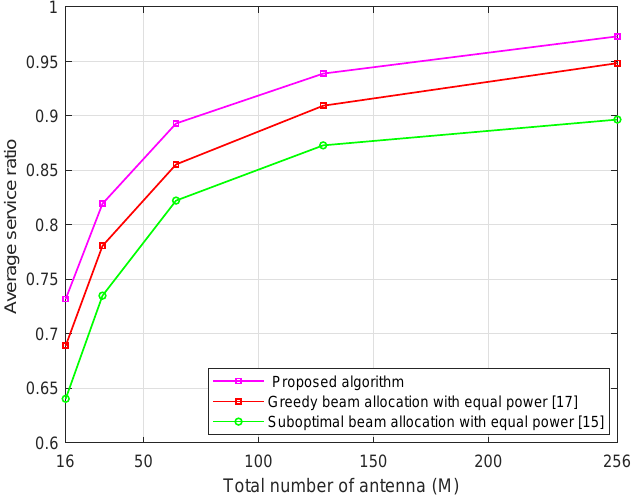
Figure 5. Average service ratio versus total number of antennas M with α = 2, U = 10, P t = 30